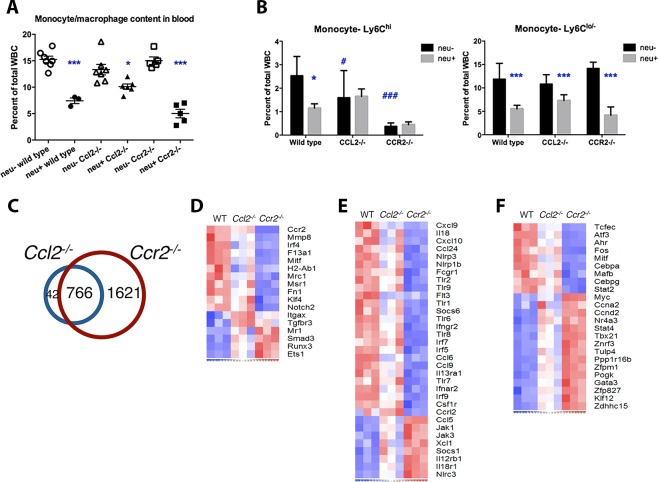
Gene expression profiling of wild type, Ccl2-/- and Ccr2-/- monocytes.(A) Monocyte proportions in the blood of tumor-free and tumor-bearing wild type, Ccl2-/- and Ccr2-/- mice were measured using flow cytometry. (Total leukocyte counts were similar in all three genotypes and unaffected by tumors.) Results were compared using one-way ANOVA and Bonferroni’s multiple comparison test; *, p < 0.05; ***, p < 0.001 comparing neu-
versus neu+ within each genotype. (B) Quantitation of Ly-6Chi and Ly-6Clo/–monocytes as percentages of total blood leukocytes. Comparisons were made by multiple t-tests. *, p < 0.05; ***, p < 0.001, neu-
versus neu+ within each genotype. #, p < 0.05; ###, p < 0.001, wild type versus Ccl2-/- or Ccr2-/- mice. (C) Venn diagram of genes differentially expressed between wild type and Ccl2-/- monocytes, and between wild type and Ccr2-/- monocytes; 766 genes overlap between the two sets, 42 are unique to the Ccl2-/- set and 1621 are unique to the Ccr2-/- set. (D-F) Heat maps of genes that characterize Ly-6Chi
versus Ly-6Clo/–monocytes (B), monocyte development and function (C), and transcription factors (D).